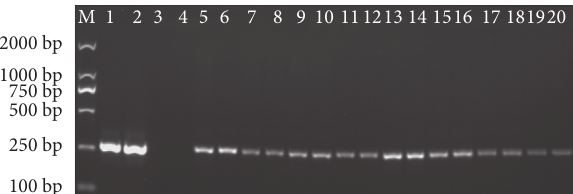
Figure 10: PCR detection of 16S–23S of C. sakazakii in Flammulina velutipes collected from 8 supermarkets. M , DNA marker D (100 ∼ 2000bp); lanes 1-2, positive control; lane 3, negative control; lane 4, blank control; and lanes 5–20, PCR results of 8 samples, respectively; each sample was tested twice.